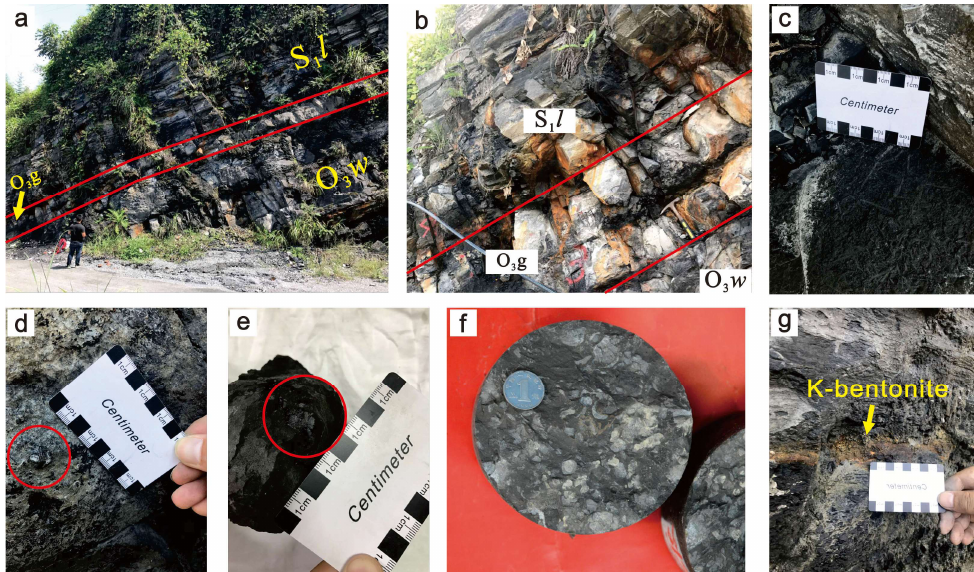
Figure 2. Field and rock core photographs of the organic-rich shales in the Wufeng and Longmaxi Formations of the Upper Yangtze region. ( a ) Continuous deposition of organic-rich shales in the Wufeng Formation (O 3 w ) and Longmaxi Formation (S 1 l ); ( b ) calcareous siliceous shales in the Guanyinqiao Member (O 3 g ); ( c ) siliceous shales in the Wufeng Formation with a large number of graptolites; ( d – f ) calcareous siliceous shales in the Guanyinqiao Member with a large number of Hirnantian Brachiopoda fossils; ( g ) intercalated layers of K-bentonites. ( a – e , g ) Are photographs of the Shuanghe profile, ( f ) is a photograph of a rock core from Well A.